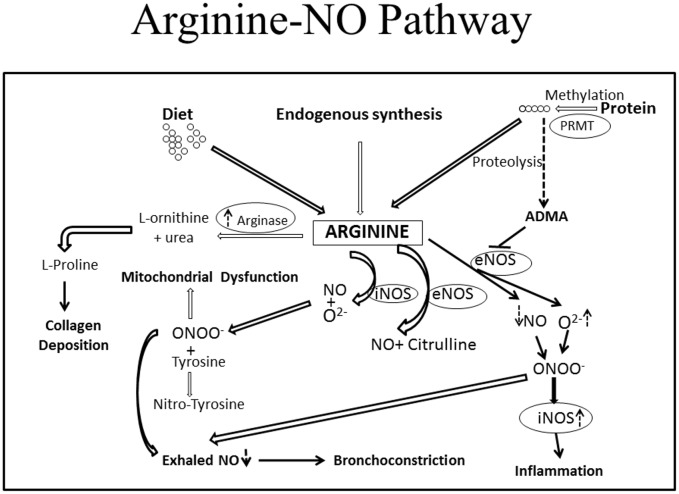
Arginine-NO pathway.